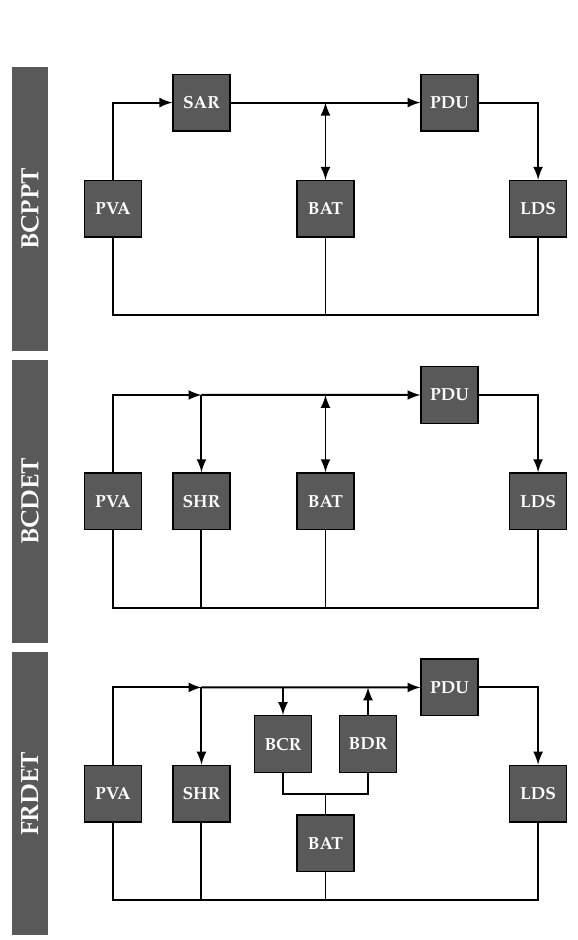
Figure 1. Block diagrams of common architecture